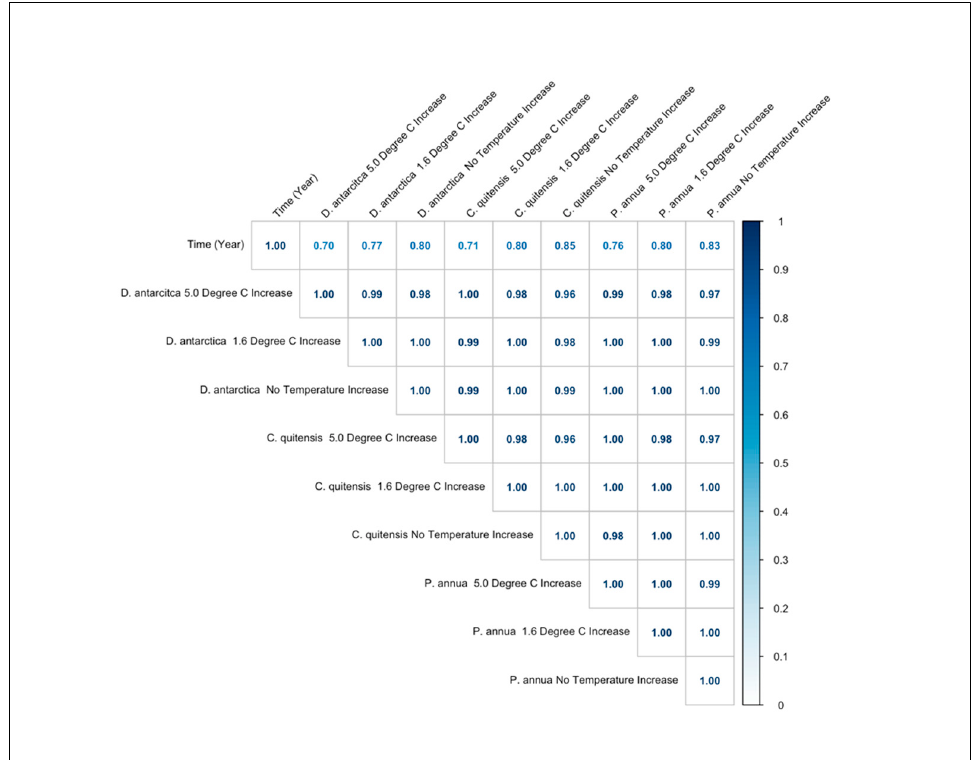
Figure 14. D. antarctica, C. quitensis and P. annua Occurrence Value Correlation Coefficients.